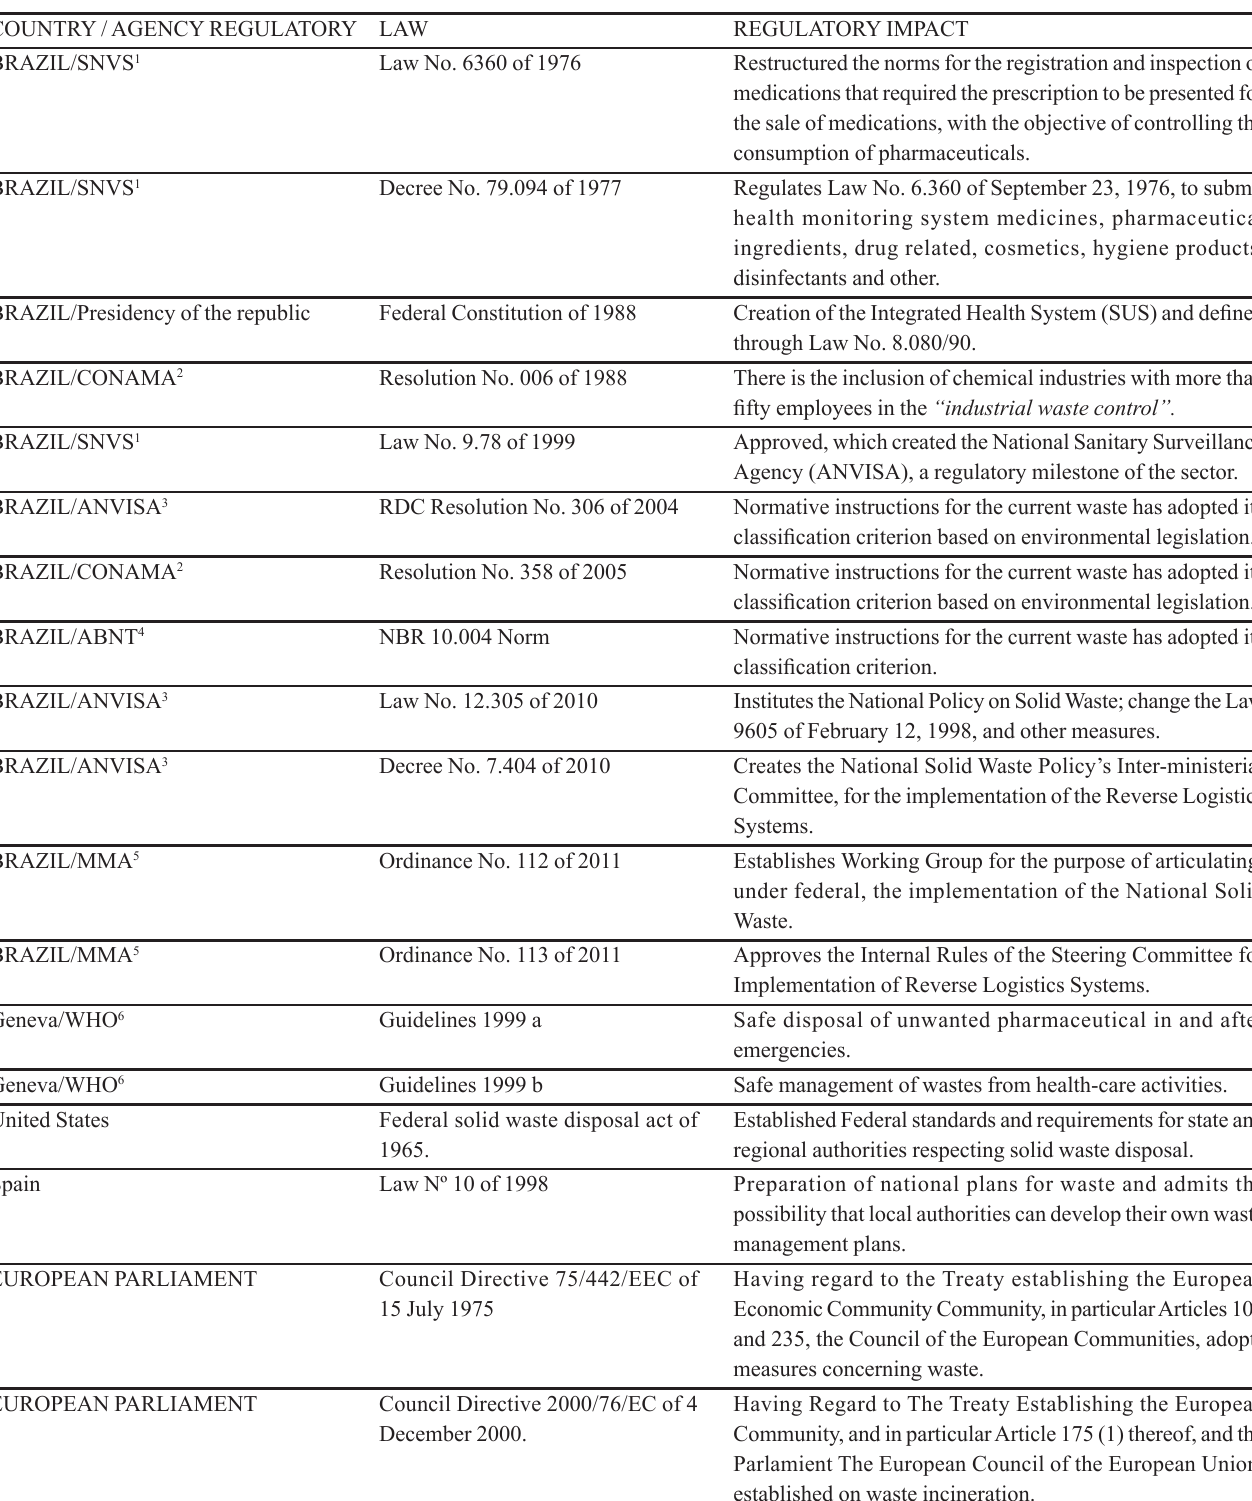
TABLE I - Main national and international laws for solid waste of medicinal